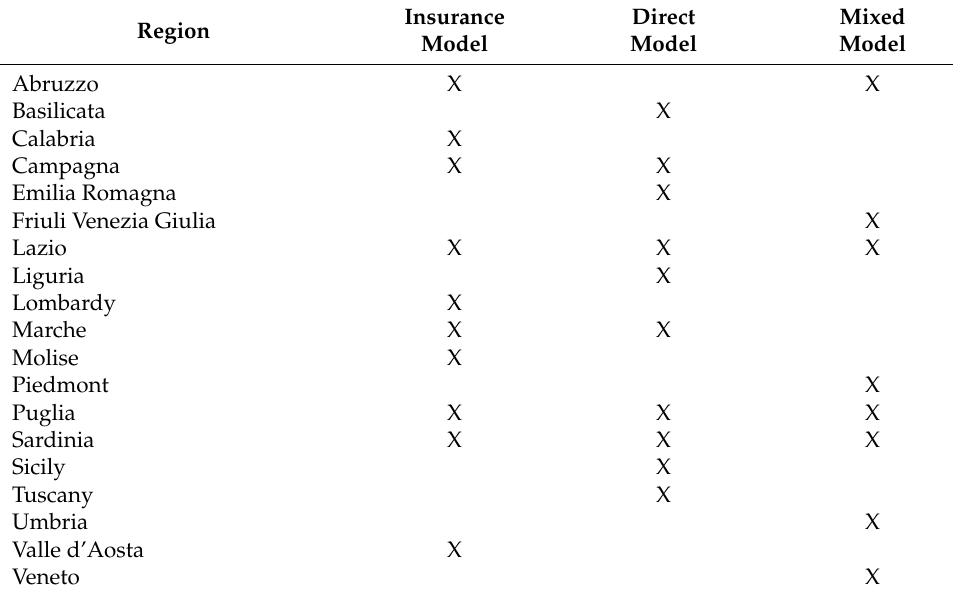
Table 1. The models of compensation for damages.